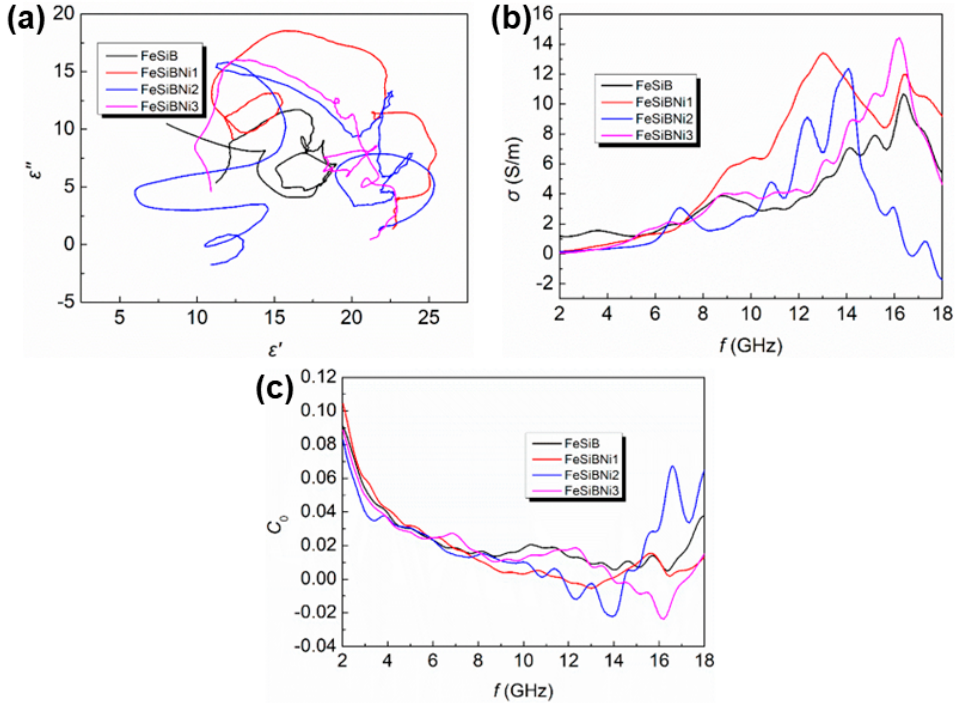
Figure 9. Loss mechanism of as-prepared Ni–doped Fe–based metallic microwires/paraffin matrix composites at 2–18 GHz: ( a ) Cole–Cole curves; ( b ) frequency dependence of dielectric conductivity; ( c ) frequency dependence of eddy current loss.